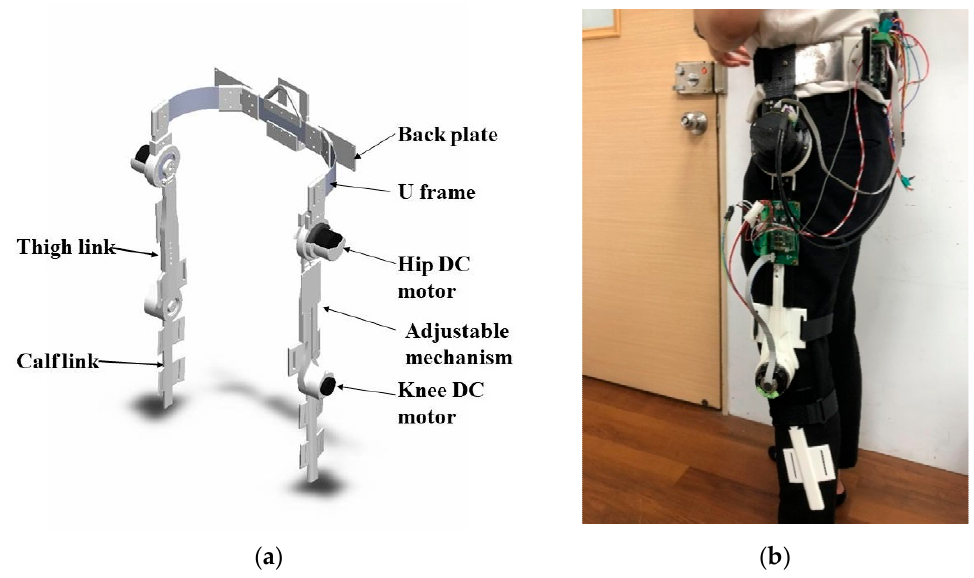
Figure 1. ( a ) Design of robotic hip-knee exoskeleton. ( b ) Building and wearing of proposed robotic knee-hip exoskeleton.